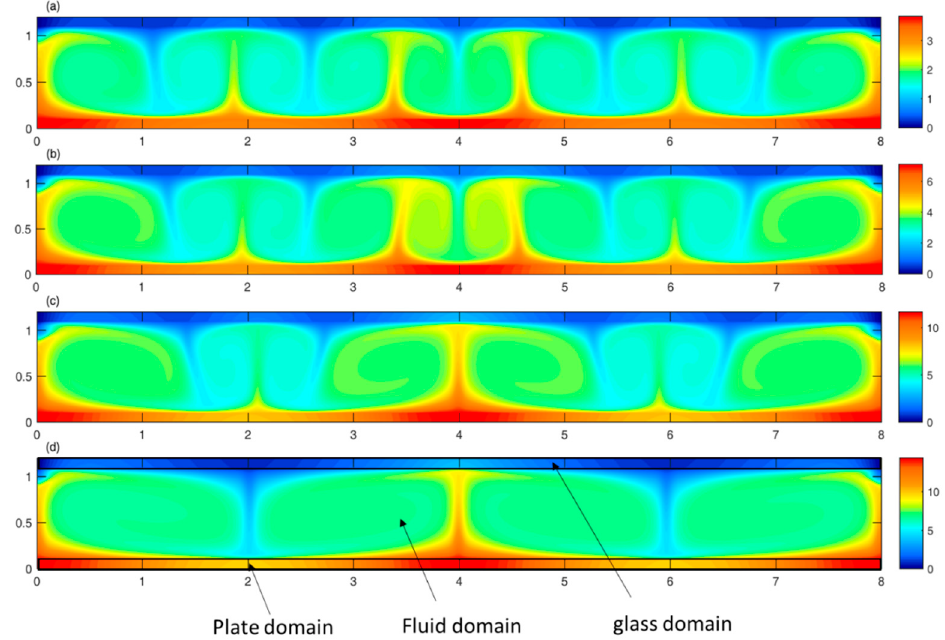
Figure 7. Isothermal contours for Ra = 10 5 , at time period of ( a ) 0.5 s, ( b ) 1 s, ( c ) 2 s, ( d ) 3 s, showing the plate domain, annulus air gap i.e., fluid domain and glass domain.